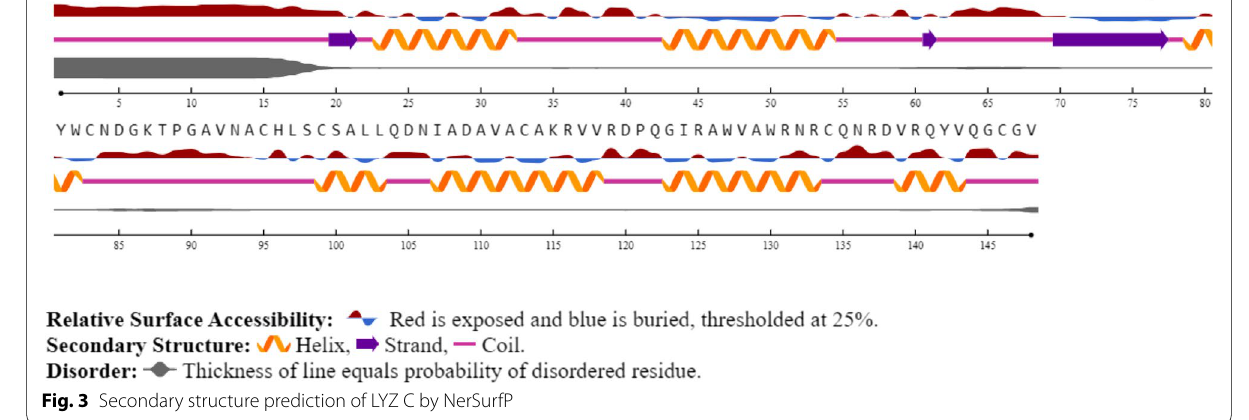
Fig. 3 Secondary structure prediction of LYZ C by